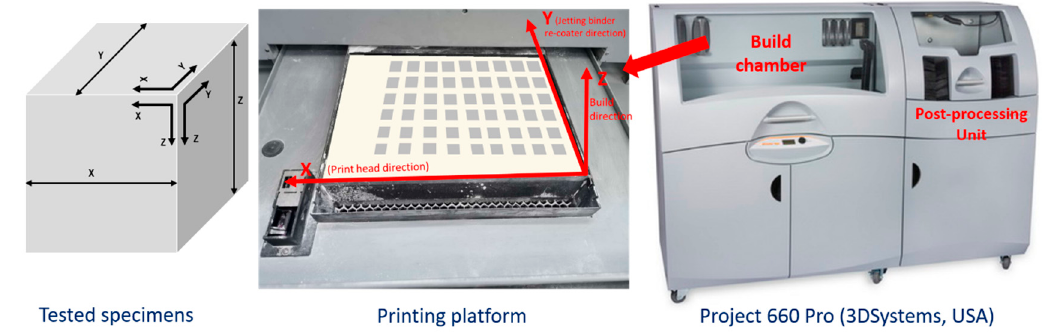
Figure 1. Printing machine, work platform and specimens printed.